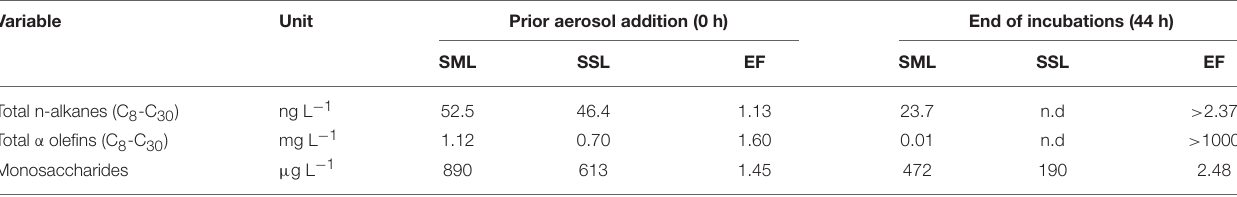
TABLE 1 | Dissolved 6 [alkanes ( C 8 − C 30) ], 6 [ α -olefins ( C 11 − C 32) ] and monosaccharides in the SML and SSL, prior (T0) and 44 h after (T44) aerosol addition.